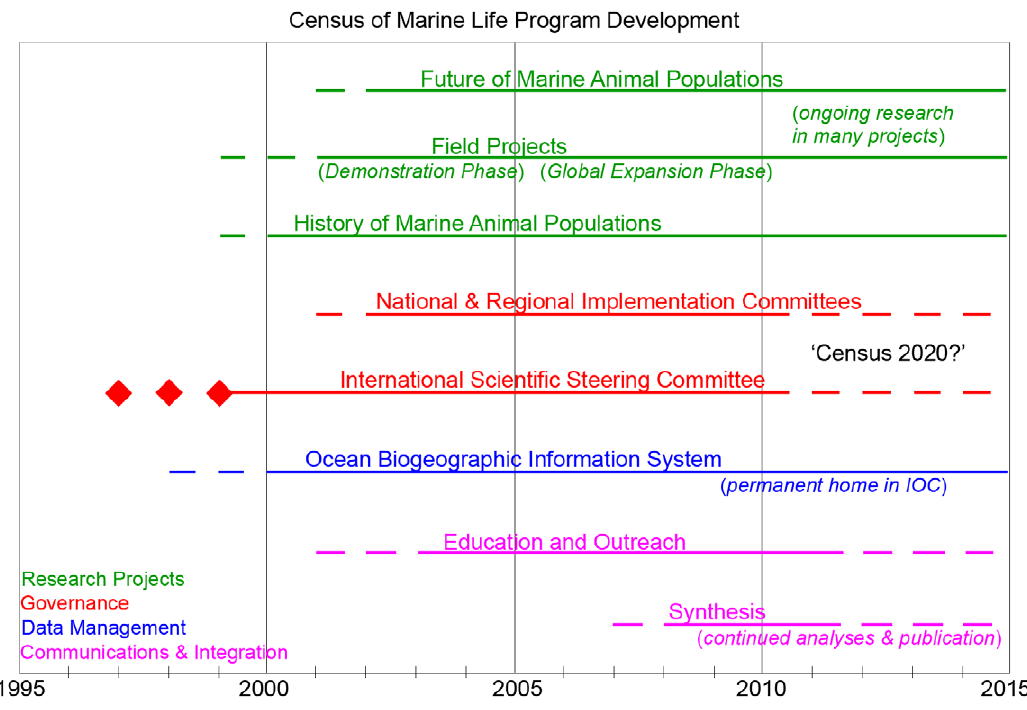
Figure 1. Historical development of the Census of Marine Life and projected continuation of its various components. The Census timeline began with the concept meetings in 1997 and the implementation of the program and its components followed as represented in this timeline. While the Census program will conclude at the end of 2010, many of its components will continue independently beyond 2010.